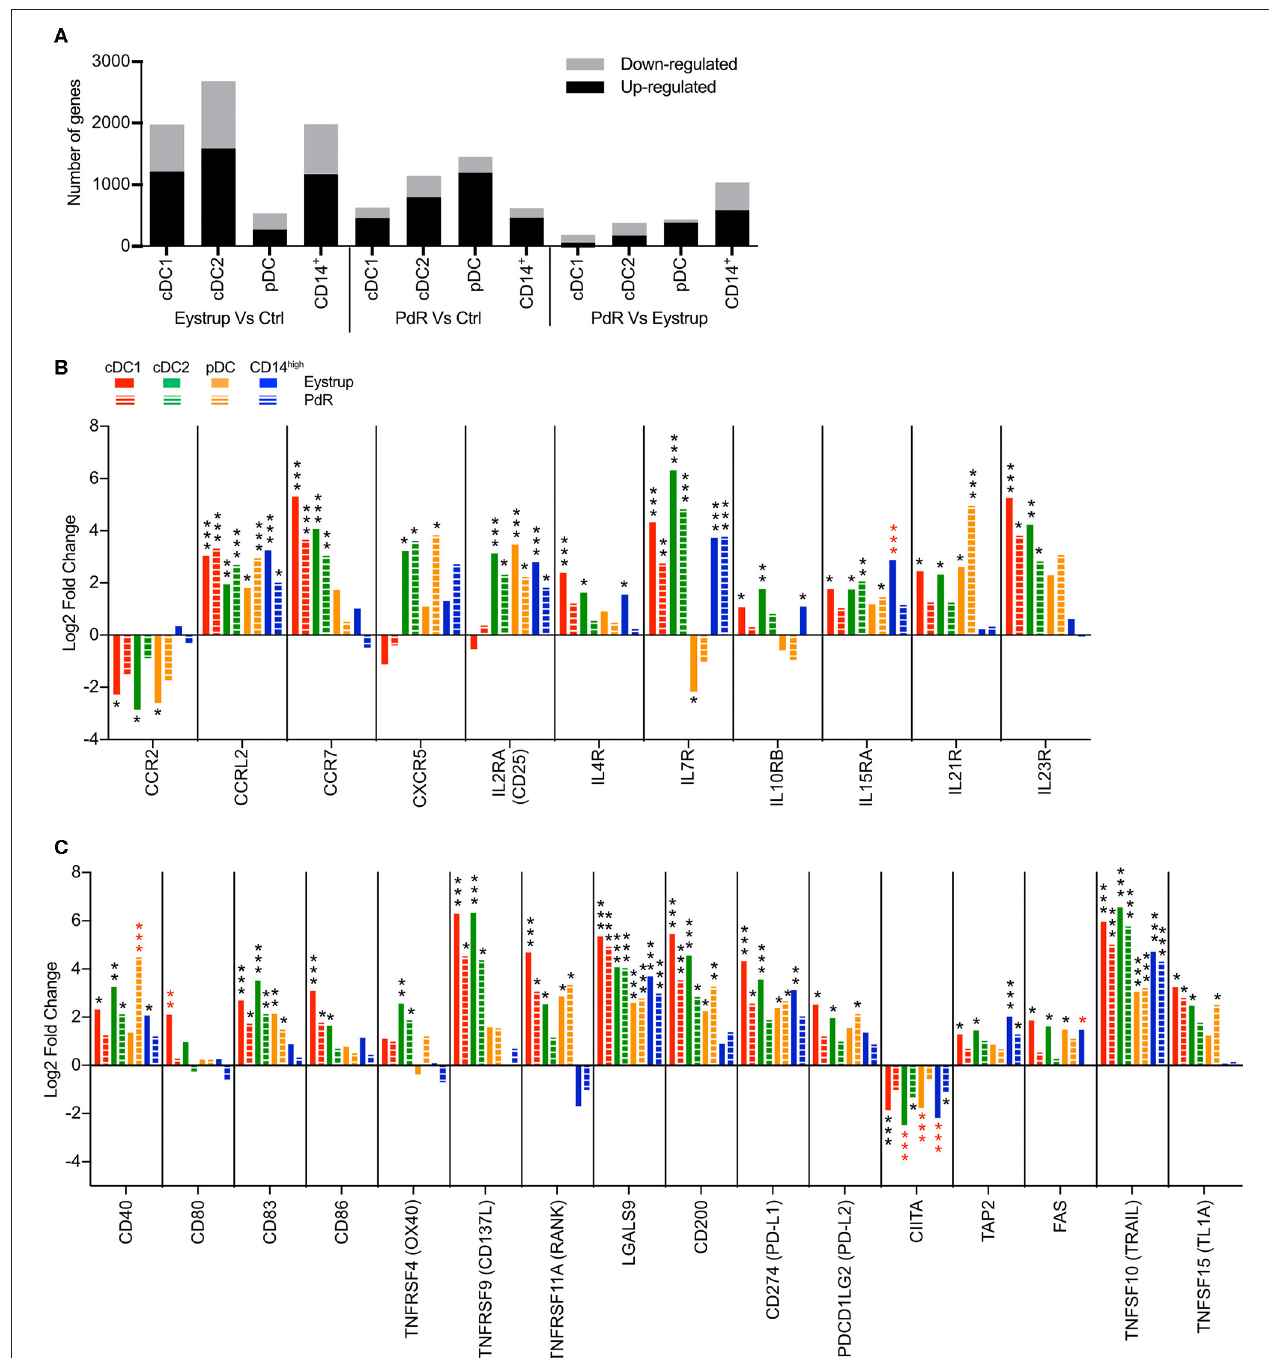
FIGURE 6 | Transcription profiles of LN mononuclear phagocytes after infection with a highly virulent (Eystrup) or a low virulent (PdR) strain of CSFV. cDC1, cDC2, pDC, and CD14 high populations were isolated from mandibular and retropharyngeal LN of animals either infected with Eystrup, PdR or left uninfected at 42h p.i. and their transcriptome was sequenced by RNA-Seq. (A) Number of significantly regulated genes (padj < 0.05 in DESeq2 analysis) when comparing cell subsets from Eystrup-infected animals and PdR-infected animals to their counterparts from uninfected animals or comparing subsets between Eystrup- and PdR-infected animals. (B) Significantly modulated expression of chemokine and cytokine receptor genes displayed as log2 fold change between Eystrup-infected (solid columns) or PdR-infected (dashed columns) and control animals. (C) Significantly modulated expression of genes related to antigen presentation and apoptosis. DESeq2 analysis * padj < 0.05, ** padj < 0.001, *** padj < 0.0001. Red-colored asterisks indicate statistical significance (Padj < 0.05) between Eystrup- and PdR-infected animals for the same cell